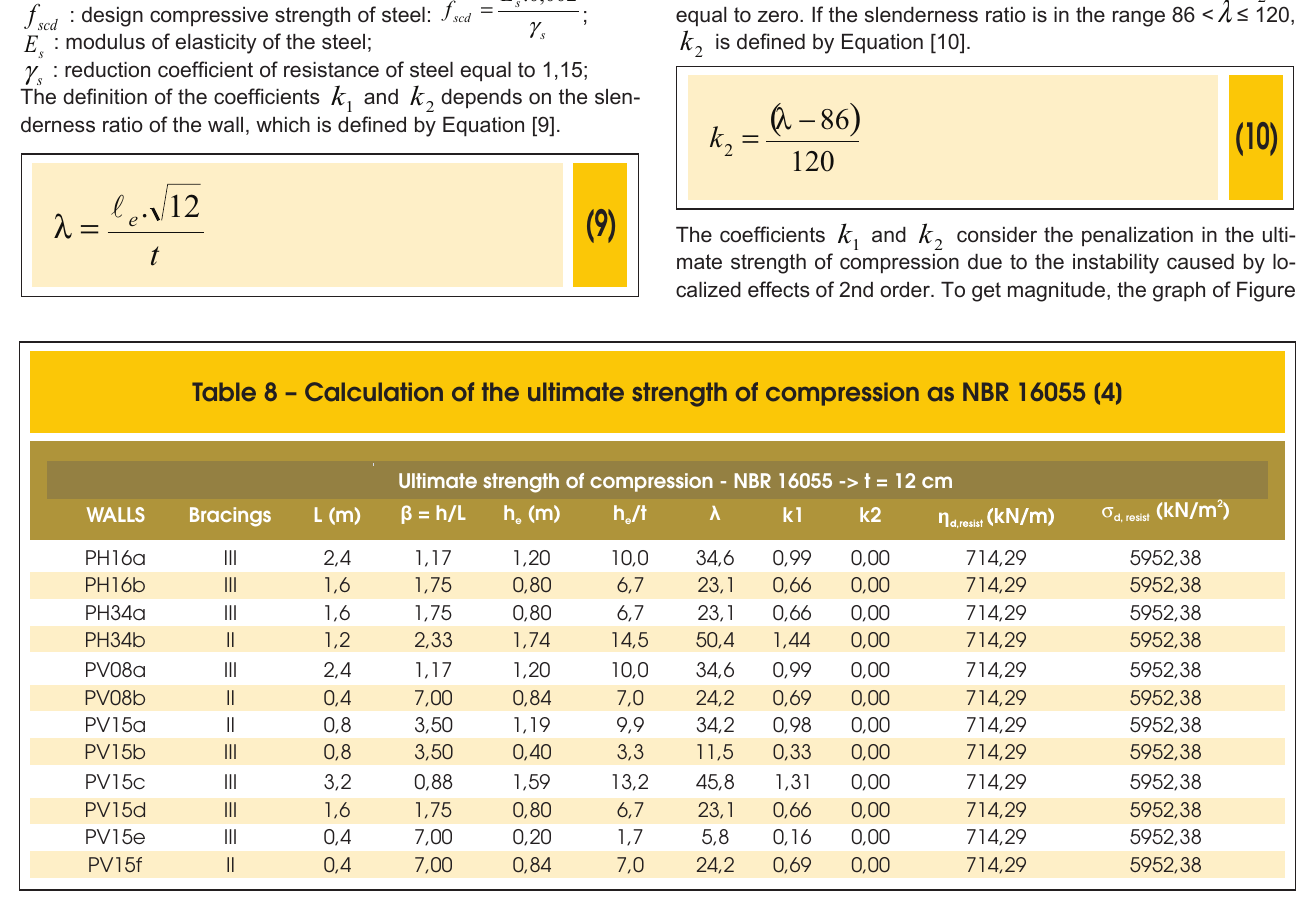
Figure 2 of NBR 16055 [4], presented here in Figure [18] in an adapted form, defines the equivalent length of the wall, depending on their bracings. λ= k /35 for any value of λ . k is defined to 35/ The coefficient 1 1 k is When the slenderness ratio is in the range 35 ≤ λ ≤ 86, 2 equal to zero. If the slenderness ratio is in the range 86 < λ ≤ 120,